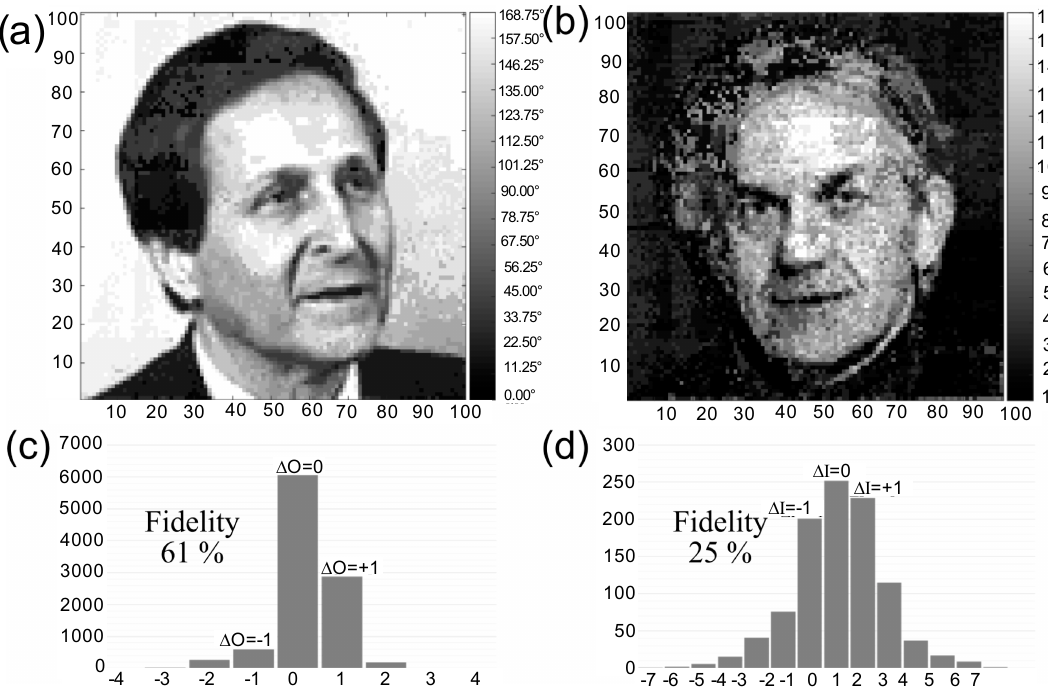
Figure 4. ( a , b ) Retrieved images from the initial images of Figure 3a,b, respectively. ( c , d ) Histograms of the level difference between original and decoded levels for the orientation direction and the fluorescence intensity, respectively.